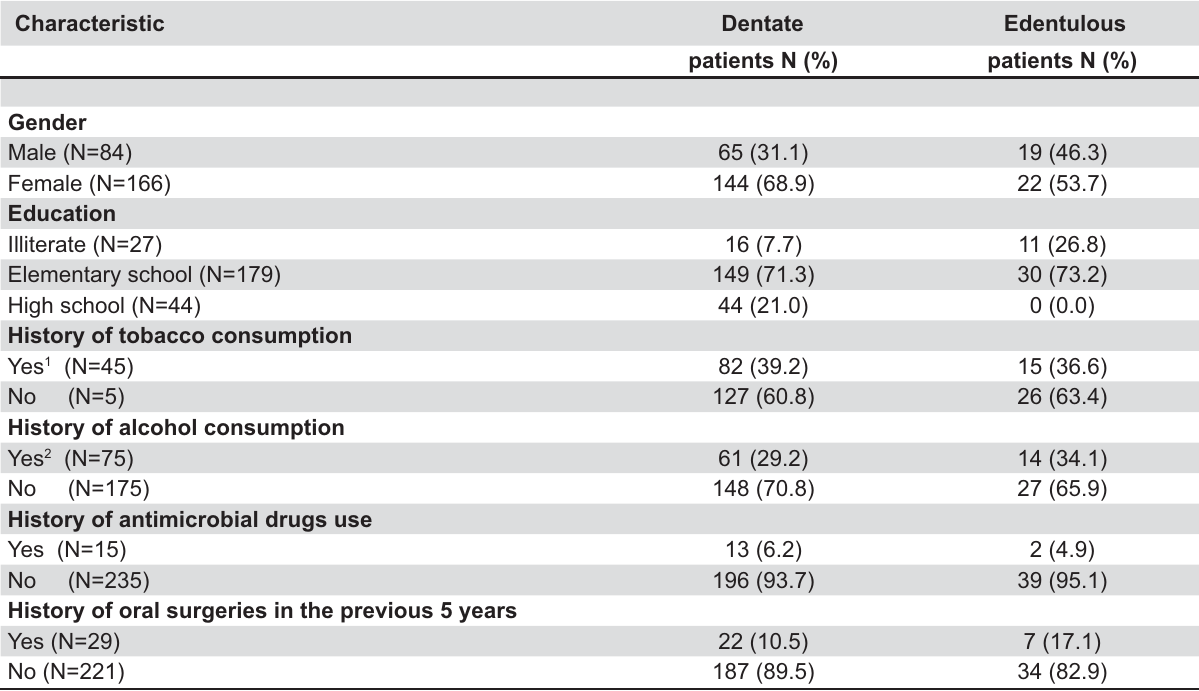
1 At least 10 cigarettes per day over the last 5 years. 2 At least two daily doses of cachaça, a distilled alcoholic beverage product of distillation of fermented sugarcane juice with alcoholic contents of 38-48%